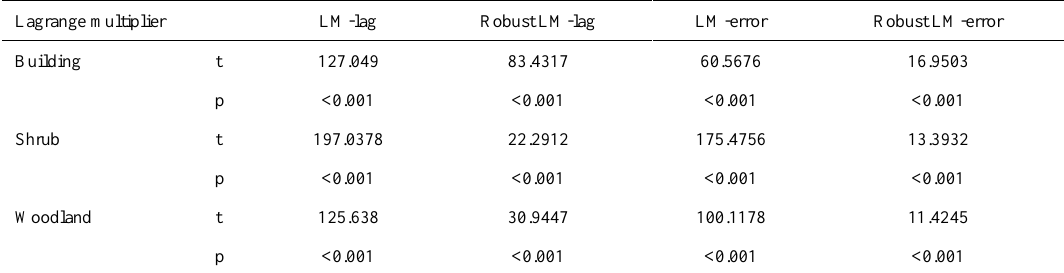
Table4 Lagrange multiplier test statistic of standard linear